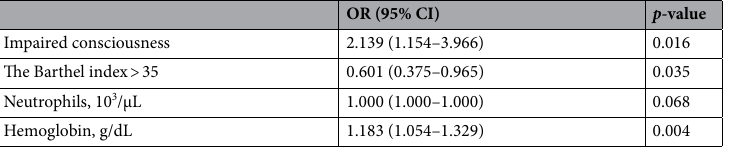
Table 2. Multivariate logistic regression analysis of the baseline characteristics associated with lower lobe- predominant distribution. CI, confidence interval; OR, odds